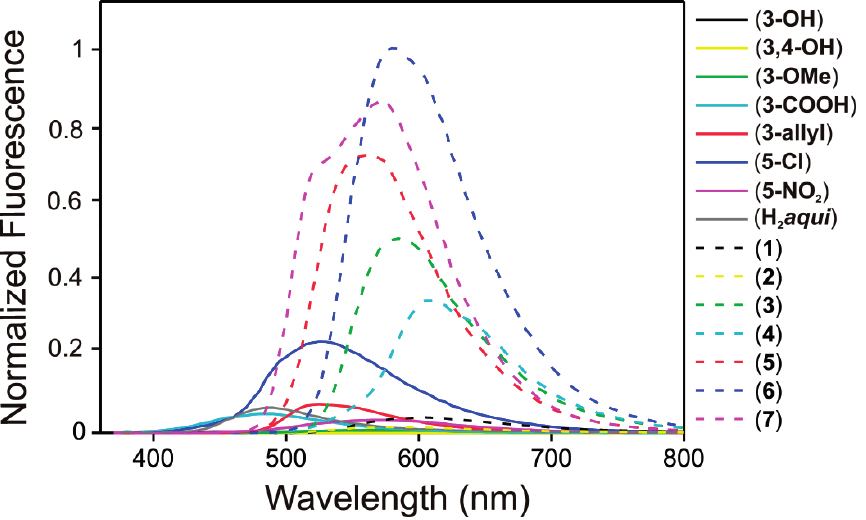
Figure 5. Normalized solid state fluorescence spectra of compounds 1 – 7 and starting compounds (salicylaldehydes and H aqui ). The comparison of intensities for the Schiff 2 bases 1 – 7 and corresponding starting compounds, where ( 3 – OH ) = 3-hydroxy- salicylaldehyde, ( 3 , 4 – OH ) = 3,4-dihydroxysalicylaldehyde, ( 3 – OMe ) = 3-methoxy- salicylaldehyde, ( 3 – COOH ) = 3-carboxy salicylic acid, ( 3 – allyl ) = 3-allylsalicylaldehyde, ) = 5-nitrosalicylaldehyde and (H aqui ) = ( 5 – Cl ) = 5-chlorosalicylaldehyde, ( 5 – NO 2 2 2-phenyl-3-amino-4(1 H